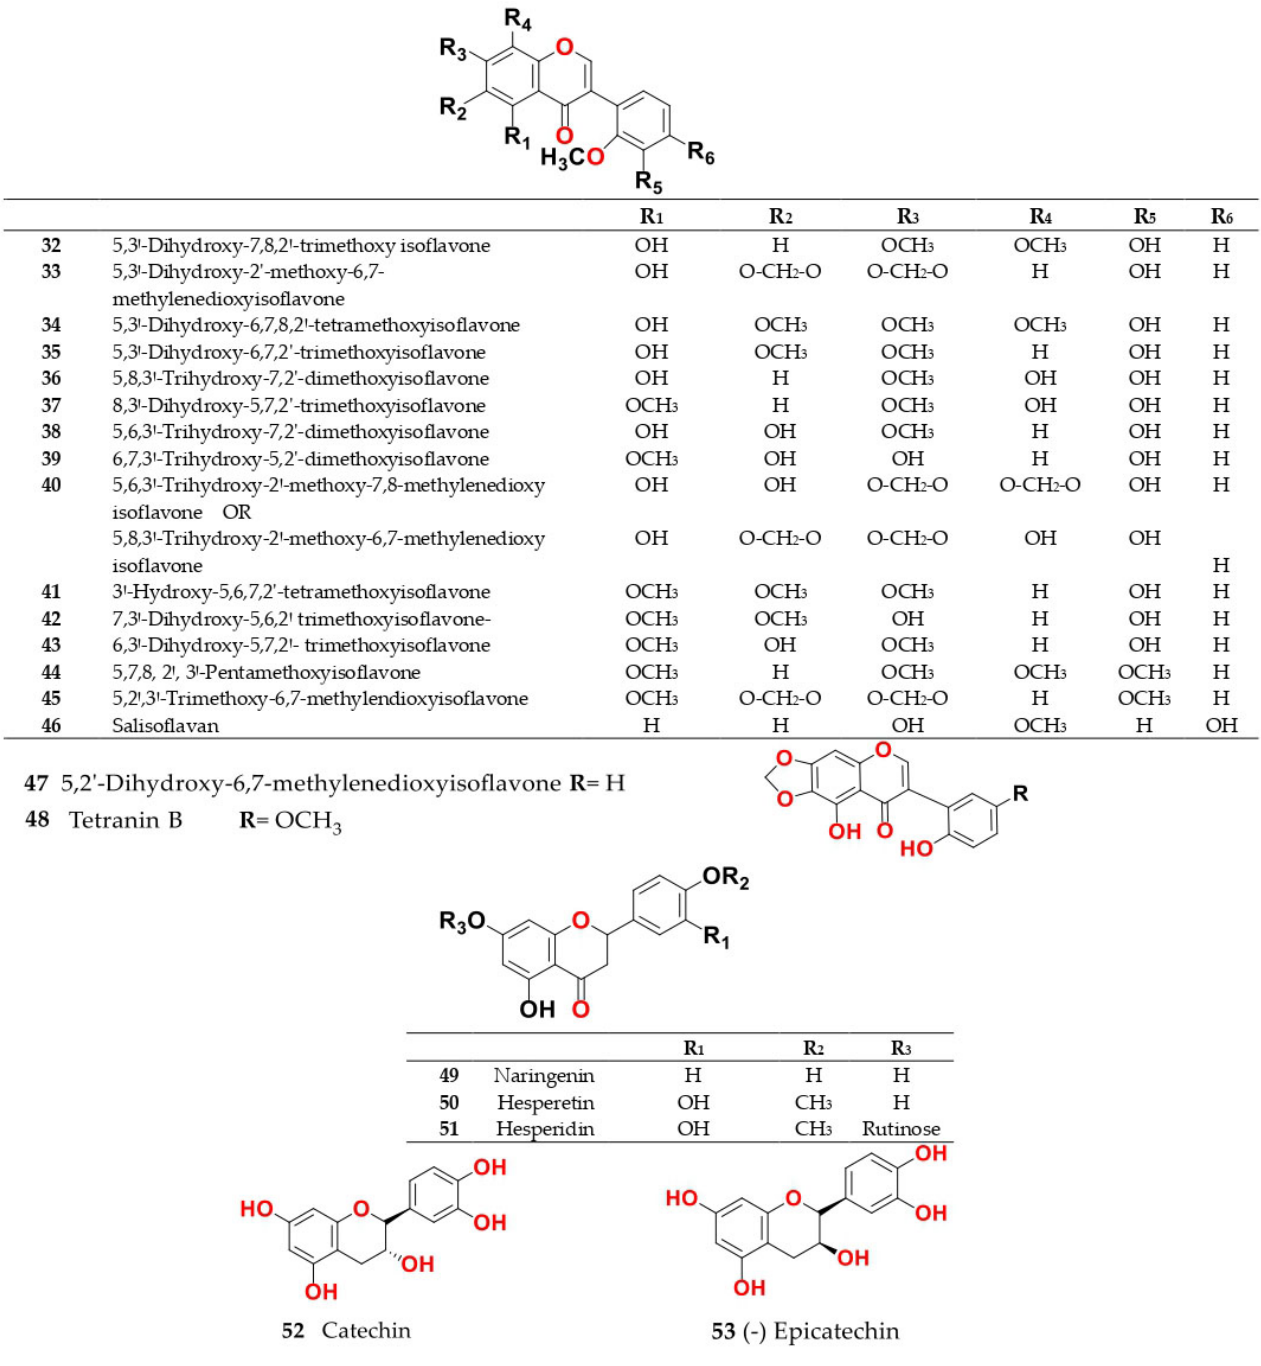
Figure 5. Chemical structure of flavonoids ( 32 – 53 ) isolated from genus Salsola